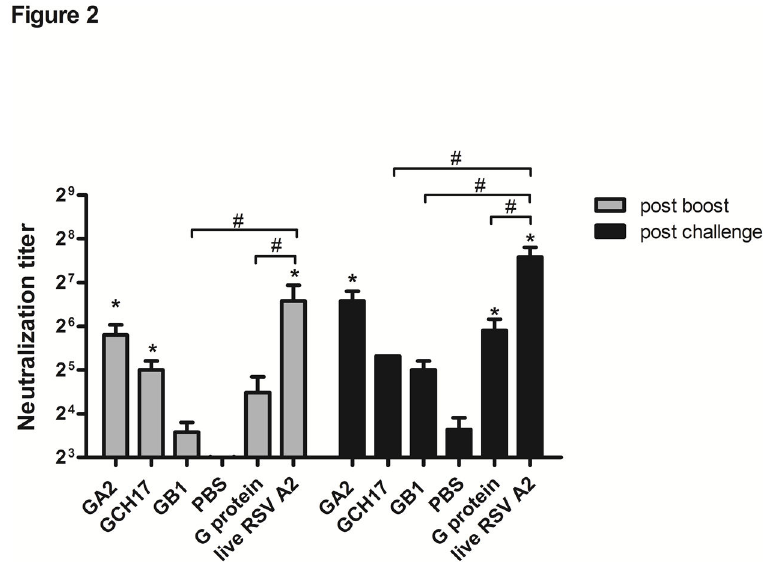
Figure 2. RSV A2 neutralizing antibodies in mice vaccinated with RSV G protein nanoparticles. Sera from vaccinated mice were evaluated for neutralizing antibodies by plaque inhibition assay. Serum samples were collected 21 days after the secondary inoculation (grey bars) and 5 days post challenge (black bars) with 10 6 PFU of RSV A2. Error bar represents the SEM from n=5 mice per group. *, #, p<0.05, significant difference as determined by one-way ANOVA and Dunnett’s test, compared with PBS vaccinated control mice (*) or compared to live RSV A2 vaccinated mice (#). doi: